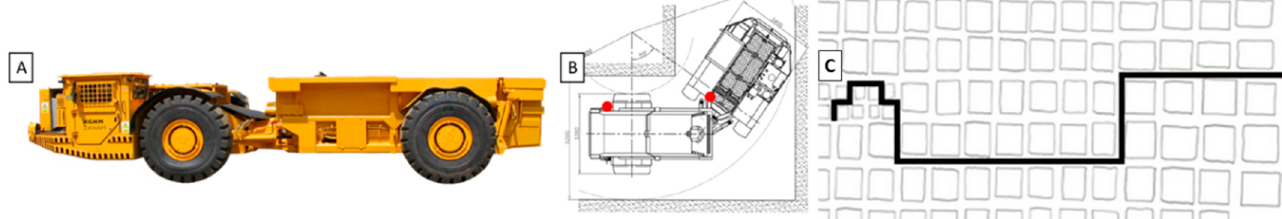
Figure 1. Investigated technical object and measurement points: ( A ) Considered haul truck; ( B ) Positions of the sensor marked with red dots; ( C ) Exemplary fragment of underground excavation with haulage path.